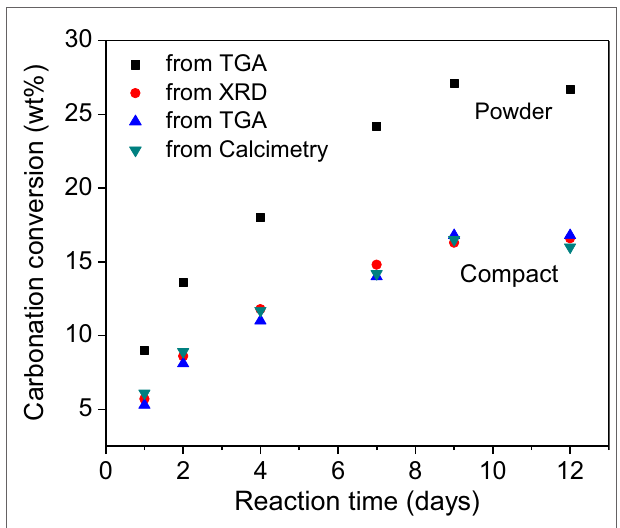
FigUre 4 | Degree of carbonation of casiO 3 powder and compact as a function of reaction time calculated from different characterization methods .